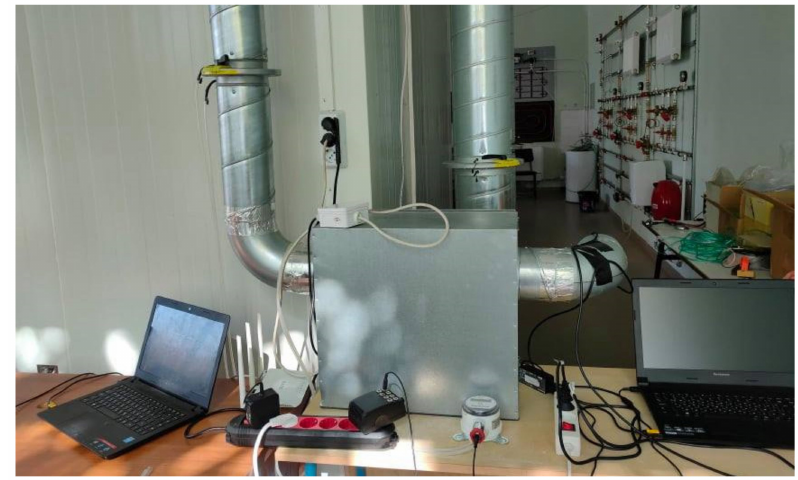
Figure 10. Measuring equipment of the climate